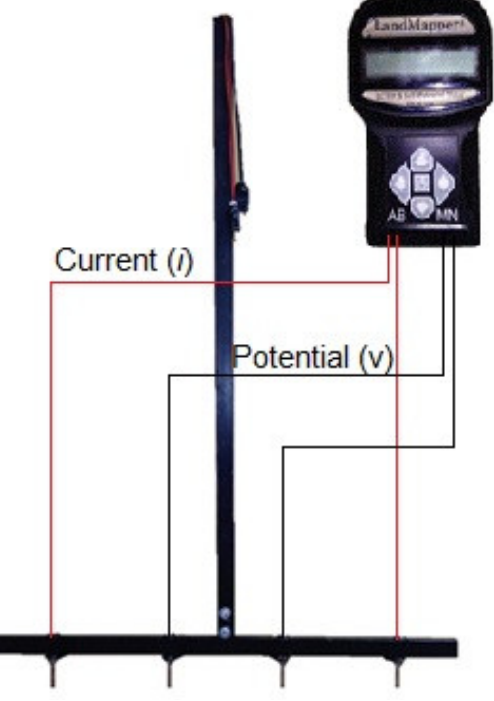
Figure 3. Wenner Matrix and portable device, LandMapper ®